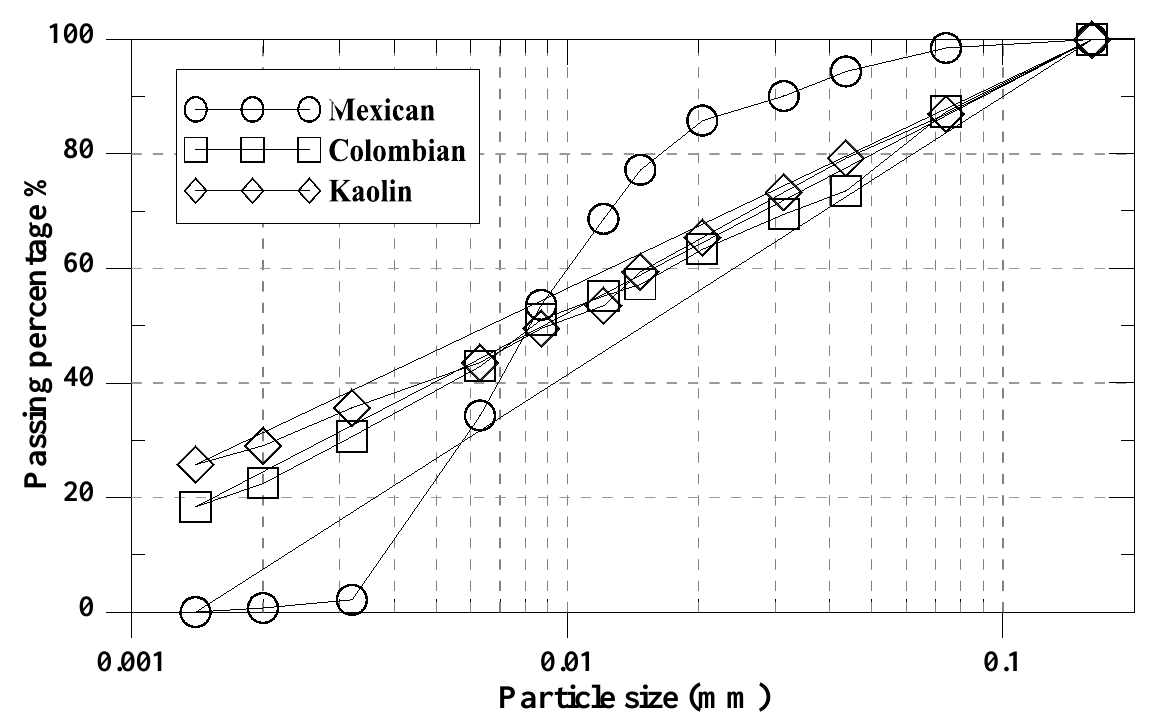
Figure 2. Particle size distribution.